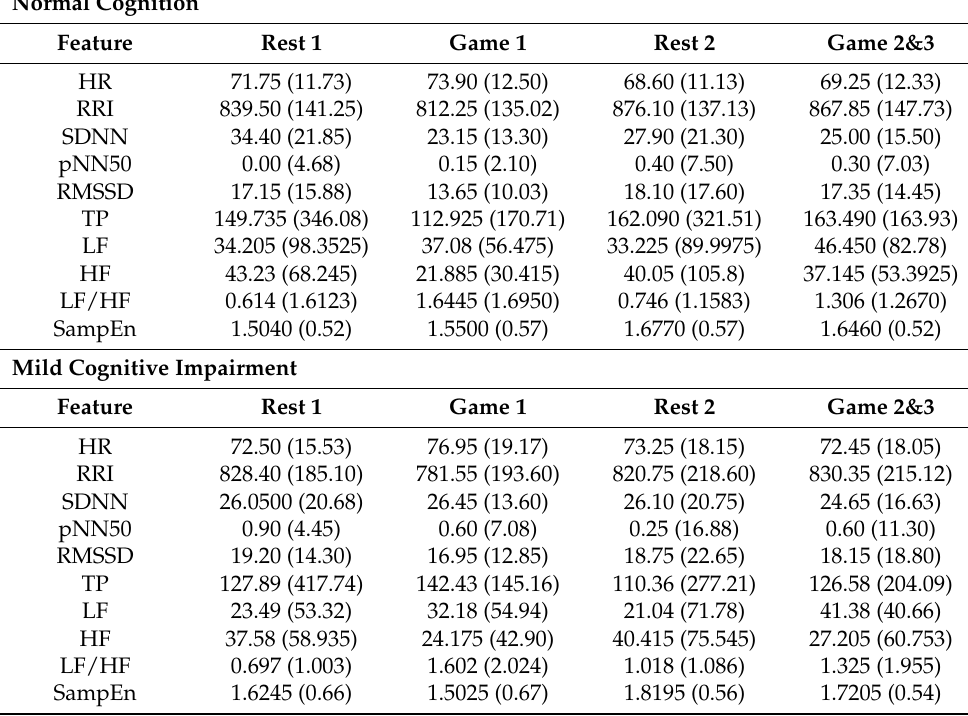
Table 3. Extracted ECG